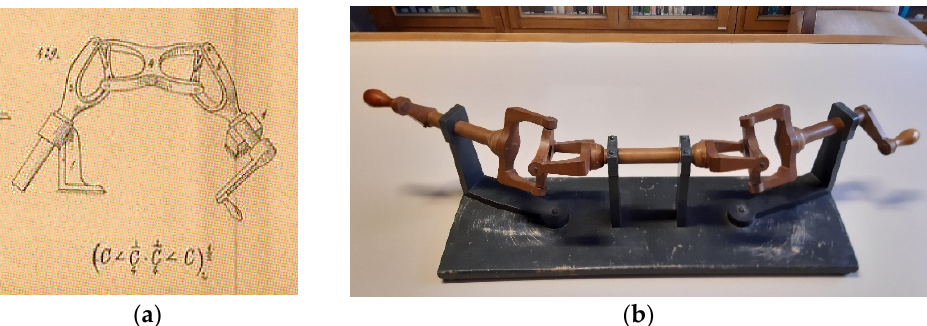
Figure 2. A model of lylindrical cam disk: ( a ) in the treatise of Masi [6]; ( b ) the corresponding wooden model at the University of Bologna.